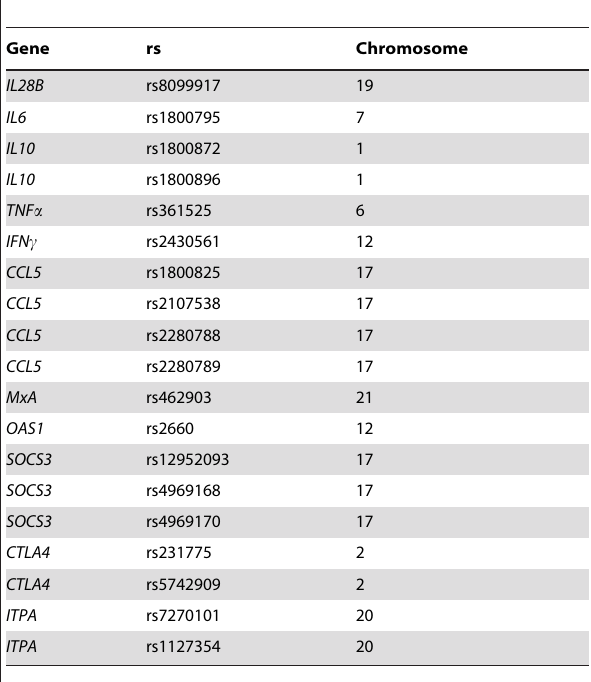
Table 1. Genes and polymorphisms